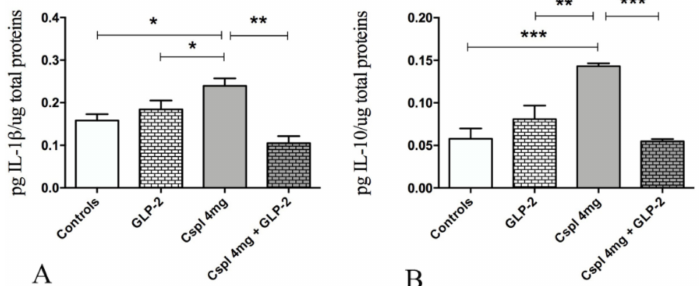
Figure 3. Evaluation of tissue pro- ( A ) and anti- ( B ) inflammatory cytokines. The measurements, performed through ELISA assay were expressed as mean ± SEM of picogram cytokines normalized for the total tissue proteins. One-way ANOVA test, post hoc Newman Keuls’. *** ( p < 0.001), ** ( p < 0.01), * ( p < 0.05). n = 4–6 for each